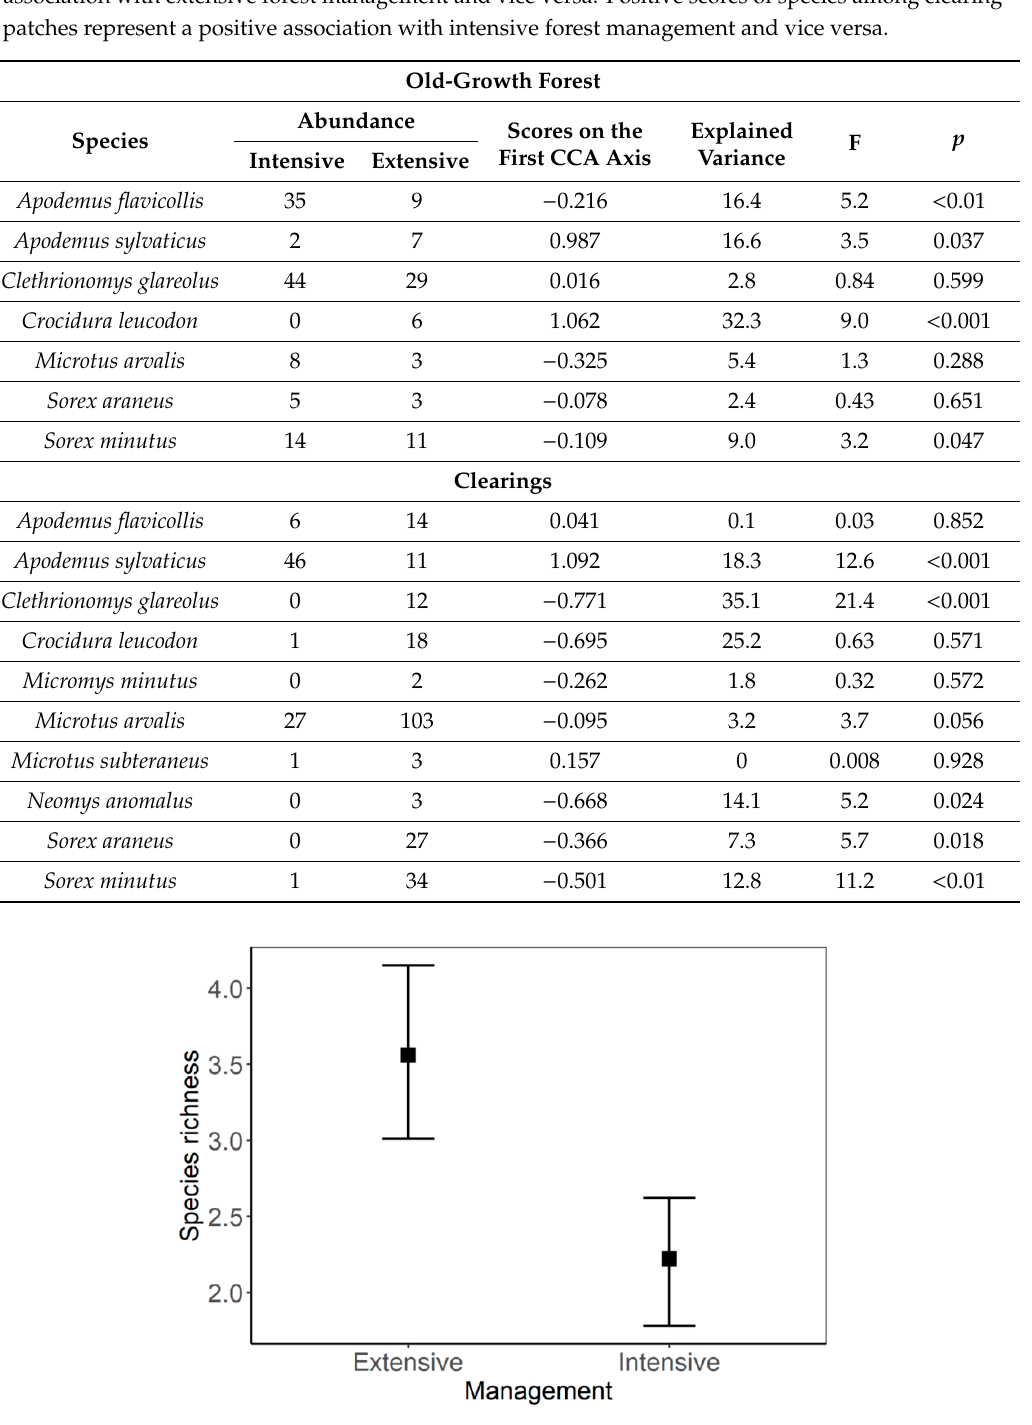
Figure 1. Effect of extensive (without soil preparation) and intensive (mechanical soil preparation) site preparation after clearcutting on small mammal species richness. Error bars represent ± 95% confidence interval.